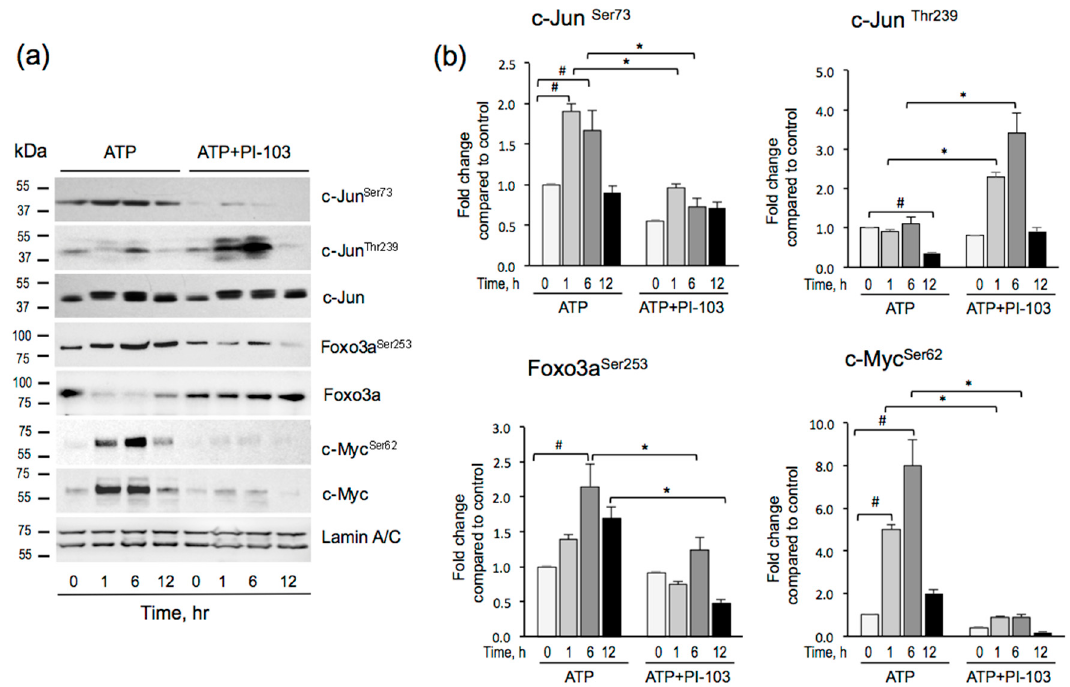
Figure 4. E ff ects of PI-103 on extracellular ATP-mediated activation of c-Jun, Foxo3a, and c-Myc in VVECs. Growth arrested VVECs, untreated or treated with PI-103 (100 nM, 1 h) were stimulated with ATP (100 µ M) for 1, 6, and 12 h. (a) Representative Western blot analysis of phospho- and total c-Jun, Foxo3a, c-Myc in nuclear fractions. (b) Quantitative analysis of phospho-c-Jun Ser73 , phospho-Foxo3a Ser253 , and phospho-c-Myc Ser62 expression in nuclear fractions. Data show phosphorylated level of each TF normalized to Lamin A / C, a nuclear fraction marker. ATP-stimulated phospho-TF levels at 1, 6, and 12 h were compared to time 0. The e ff ect of PI-103 was determined individually at each indicated time point in control and ATP-treated cells; the data represent the mean ± SEM from three to four independent experiments (n = 3–4) conducted on three cell populations. # p < 0.05 for comparison between cont vs. ATP; * p < 0.05 for comparison between control vs. PI-103 treatment (unpaired, two-tailed t test).